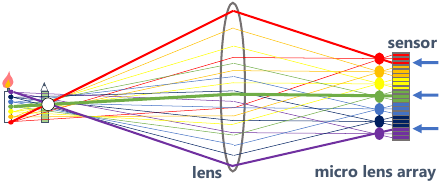
Figure 4. Multi-focus images generation